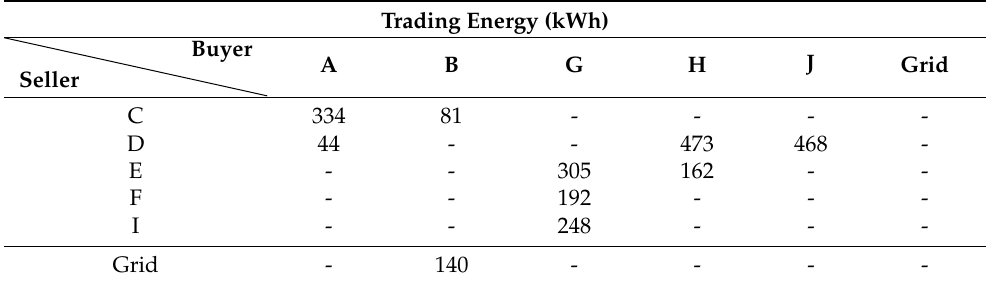
Table 6. Results of transaction: trading energy part.